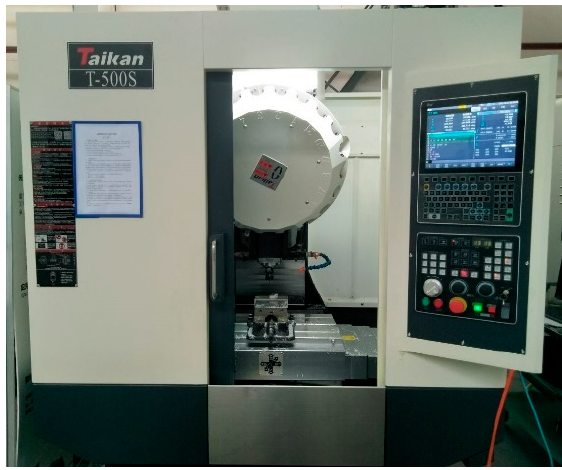
Figure 13. Taikan precision T-500S machine tool.